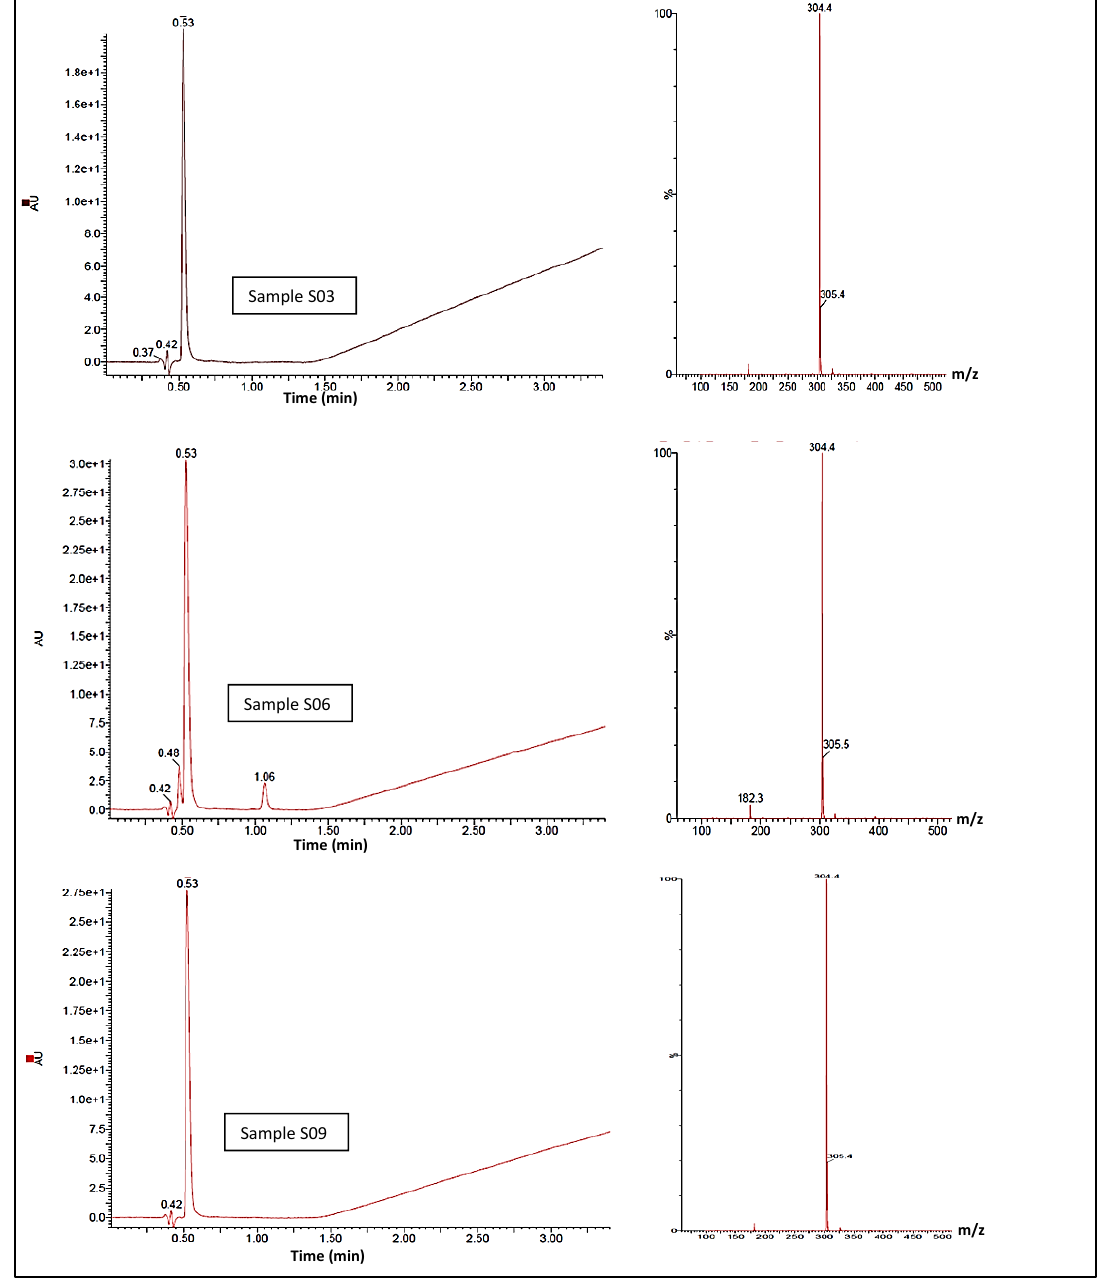
Figure 5. UHPLC-MS spectra showing cocaine elution time circa 0.53 minutes, and cocaine elution signal intensity, for samples S03, S06 and S09 (left). MS-spectra (right) for the samesamples showing abundant molecular ions at m / z 304.4 and 305.4, consistent with cocaine.